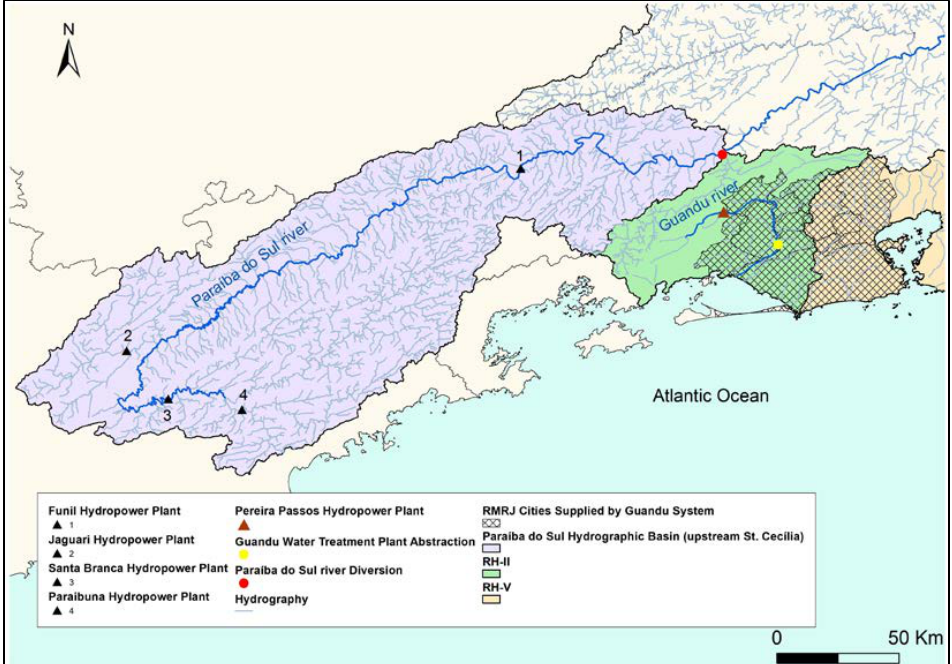
Figure 5. The W-ScaRI application area.